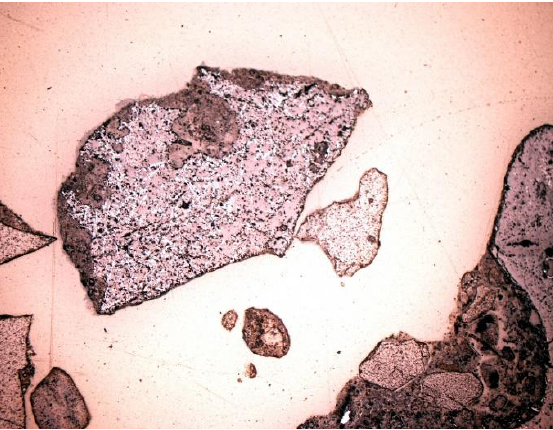
Figure 22. Metallic substance. Unburned fragment of anthropogenic origin. SP2 sample, thin section, 1P, 100×, reflected light.